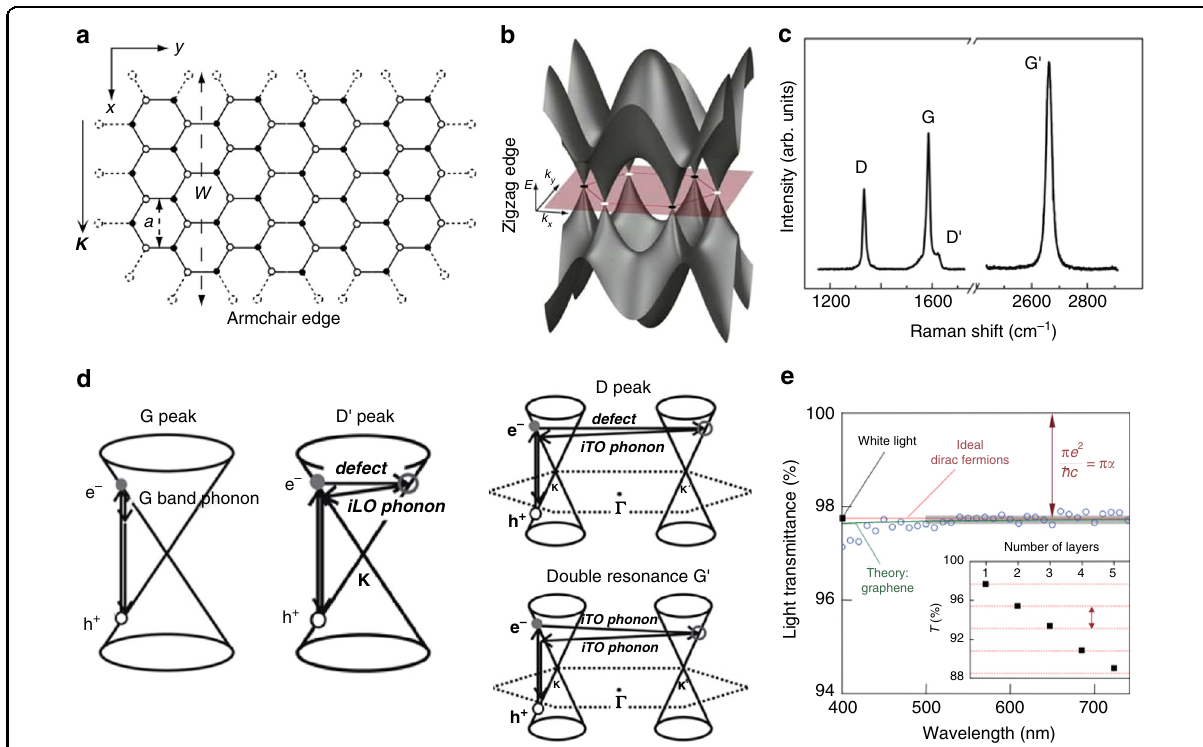
Fig. 4 Crystal and band structures, Raman responses, and optical transmission of unstrained graphene. a Honeycomb lattice of graphene, and b its band structure 90 . c Raman spectrum taken at a graphene edge 7 . d Schematic of the formation of different Raman resonances in graphene 7 . e Transmittance spectrum of single-layer graphene (open circles), with the gray bar representing the standard error of measurements. The red line is the transmittance spectrum given by T = (1 + 0.5 πα ) – 2 expected for 2D Dirac fermions, whereas the green curve is given by the theory taking into account the nonlinearity and warping effects in the electronic spectrum of graphene. The inset shows the transmittance of white light as a function of the graphene layer number (squares). The dashed lines represent an intensity reduction of πα for each added layer 89 . Reprinted a and b with permission from ref. 90 . Copyright (2008) by the American Physical Society. Adapted c and d from ref. 7 . Copyright (2009) with permission from Elsevier, from ref. 89 . Reprinted e with permission from